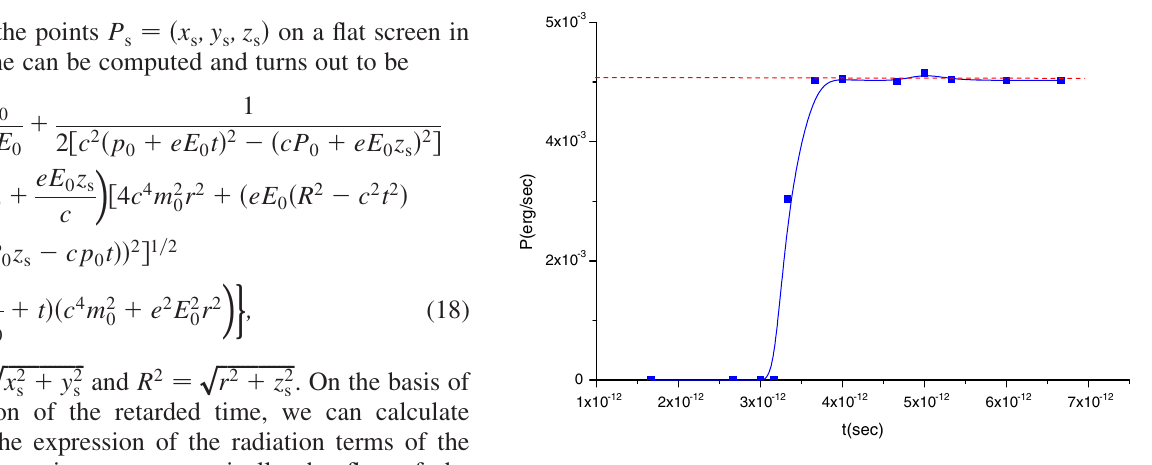
FIG. 4. (Color) The power collected on a sphere produced by a single charge under the effect of a constant magnetic field as calculated by RETAR (blue dotted line) compared to the result of the Lie´nard formula (21) (red dashed line).